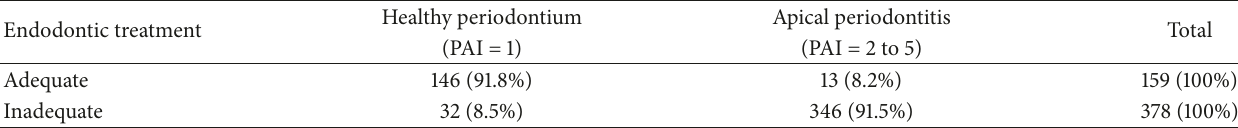
Table 2: Distribution of apical periodontitis according to the quality of endodontic treatment.